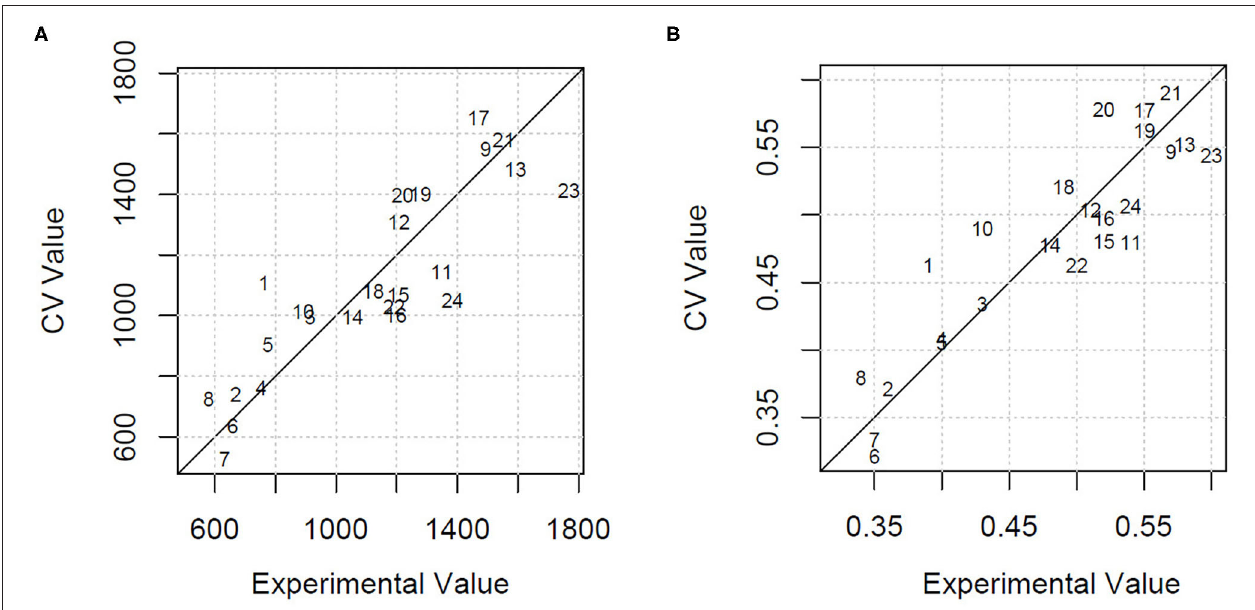
FIGURE 2 | (A) Cross-validated (CV) vs. experimental value plot obtained by the GA-PLSR model to estimate the herbage intake of lactating ewe groups submitted to different part-time grazing regimens differing for daily access time (2, 4, and 6 h/d). (B) Cross-validated (CV) vs. experimental value plot obtained by the GA-PLSR model to estimate the herbage percentage in the diet of lactating ewe groups submitted to different part-time grazing regimens differing for daily access time (2, 4, and 6